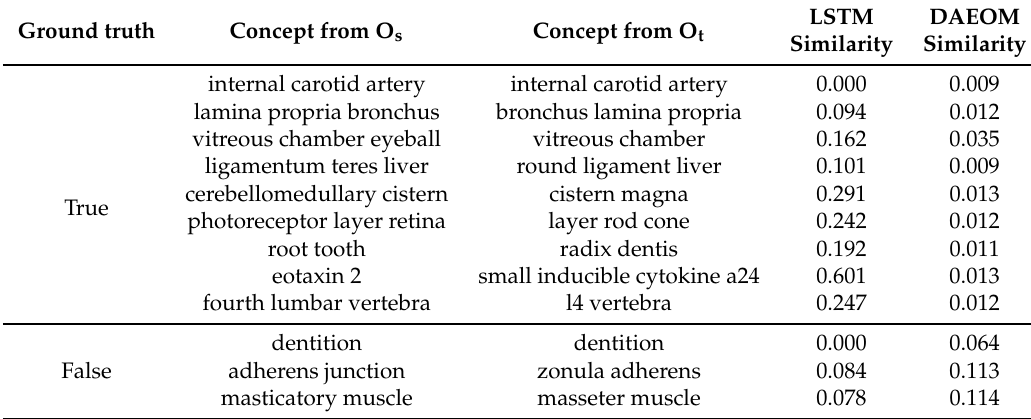
LSTM DAEOM Similarity Similarity